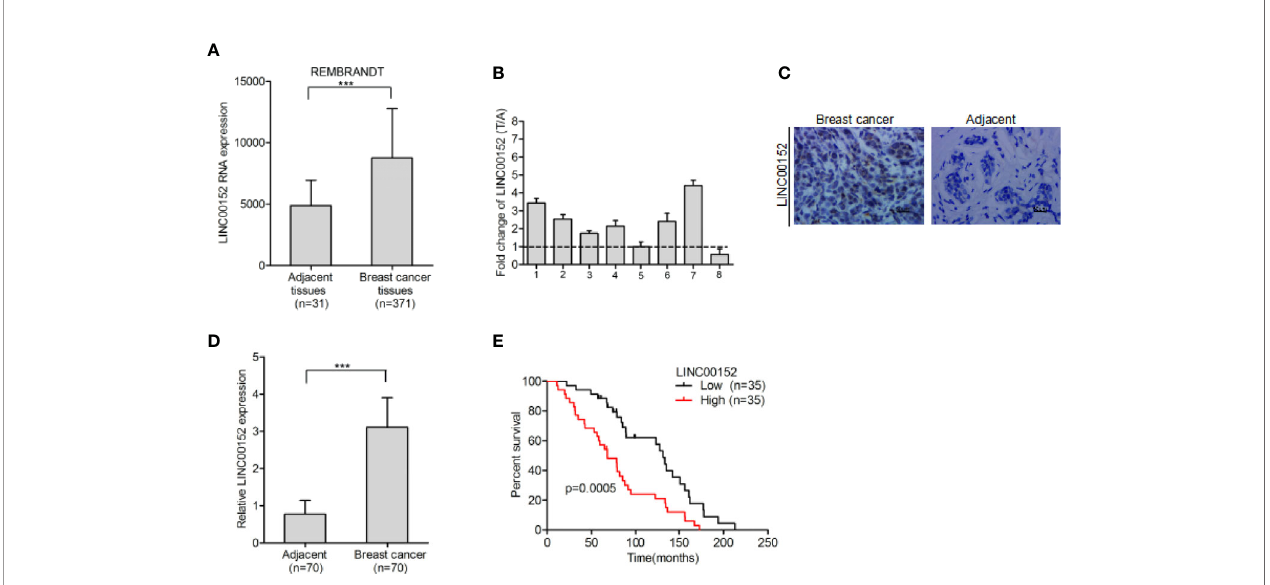
FIGURE 1 | LINC00152 is overexpressed in breast cancer and indicate poor prognosis. (A) LINC00152 is overexpressed in breast cancer cells in comparison with the adjacent normal tissues in the REMBRANDT database. (B) LINC00152 expression was detected by qRT-PCR in eight pairs of freshly frozen human breast cancer tissues and adjacent normal tissues. (C) Representative images of LINC00152 expression in paraf fi n-embedded breast cancer and paired adjacent non-tumor specimens using RNAscope. Scale bars: 50 µm. (D) Quanti fi cation of LINC00152 expression in (C) . (E) Kaplan – Meier analysis of overall survival (OS) based on LINC00152 expression in all the 70 breast cancer patients. Error bars represent the SD of each value. ***P < 0.001. Data represent three independent